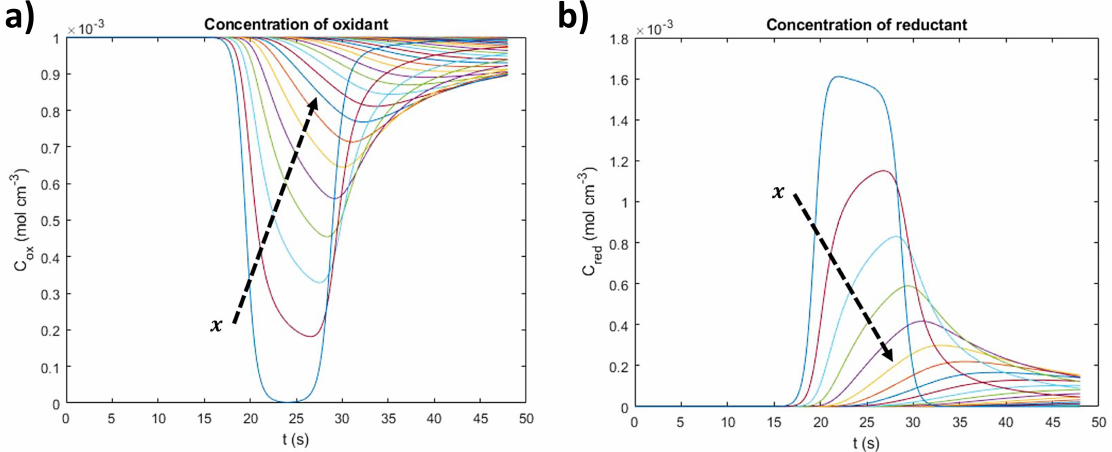
Figure 2. 1. Figure 5. Concentration over time for different distance planes for ( a ) oxidant and ( b ) reductant. The peaks of each concentration curve correspond to the maximum or minimum of the oxidant and reductant’s concentration, respectively, at ψ max . In the case of the oxidant (Figure 5a), the minimum concentration is higher as the distance to the electrode increases because the redox processes only occur at the active material’s surface or at its near-surface. The opposite situation occurs for the reductant (Figure